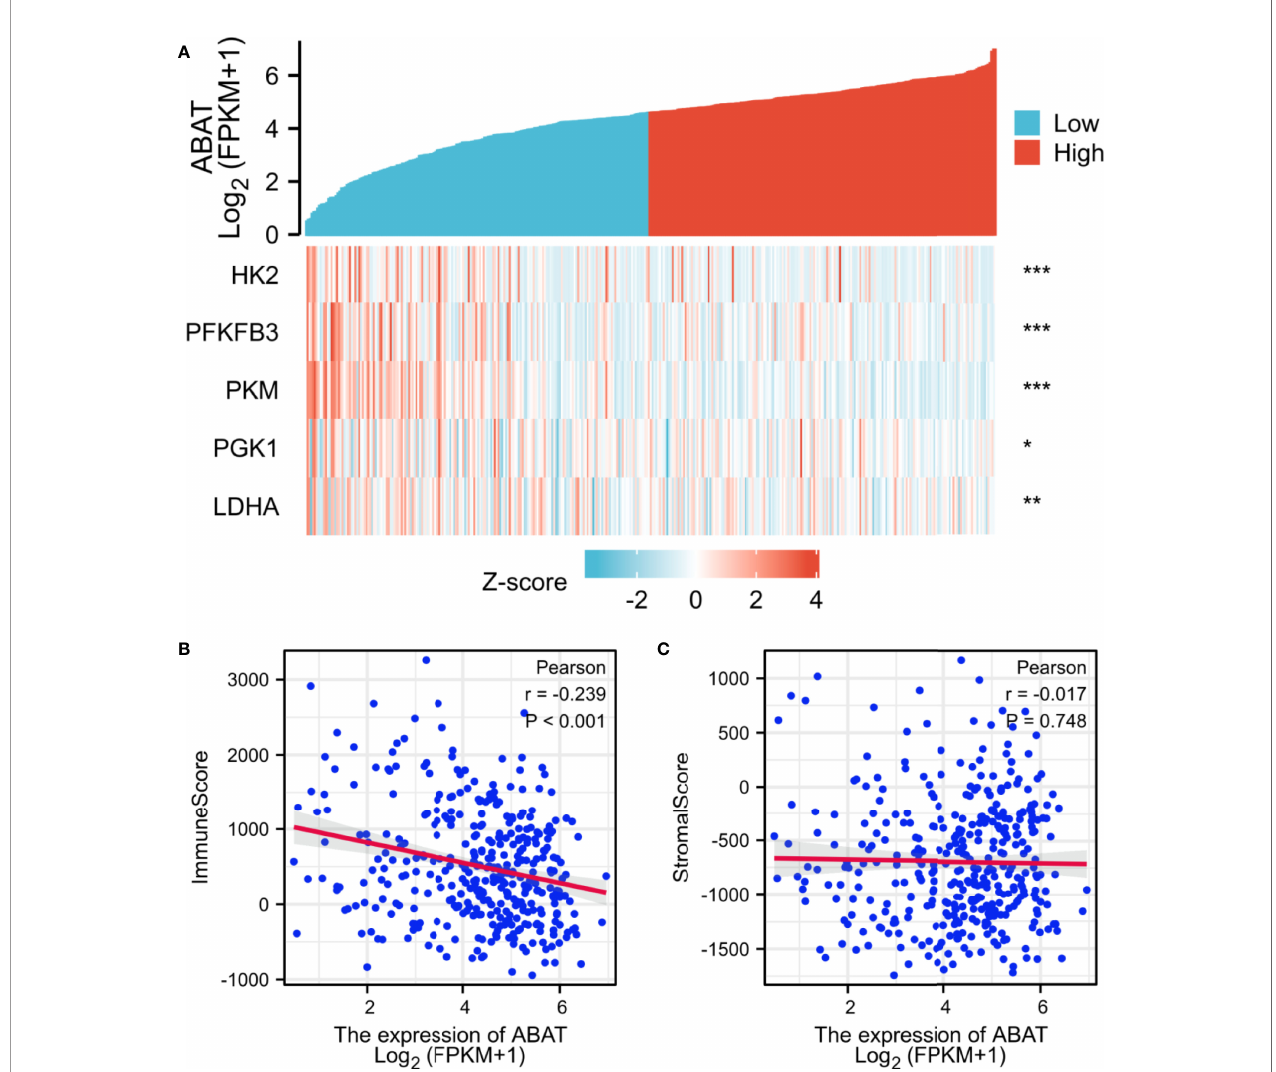
FIGURE 10 | Correlations between ABAT expression and glycolysis-related genes/tumor microenvironment. (A) The X-axis and Y-axis represent the samples and the glycolysis-related genes, respectively. Green and red tones indicate the downregulation and upregulation of genes, respectively. (B) Correlation between ABAT and immune score in HCC. (C) Correlation between ABAT and stromal score in HCC. *P < 0.05, **P < 0.01, ***P <